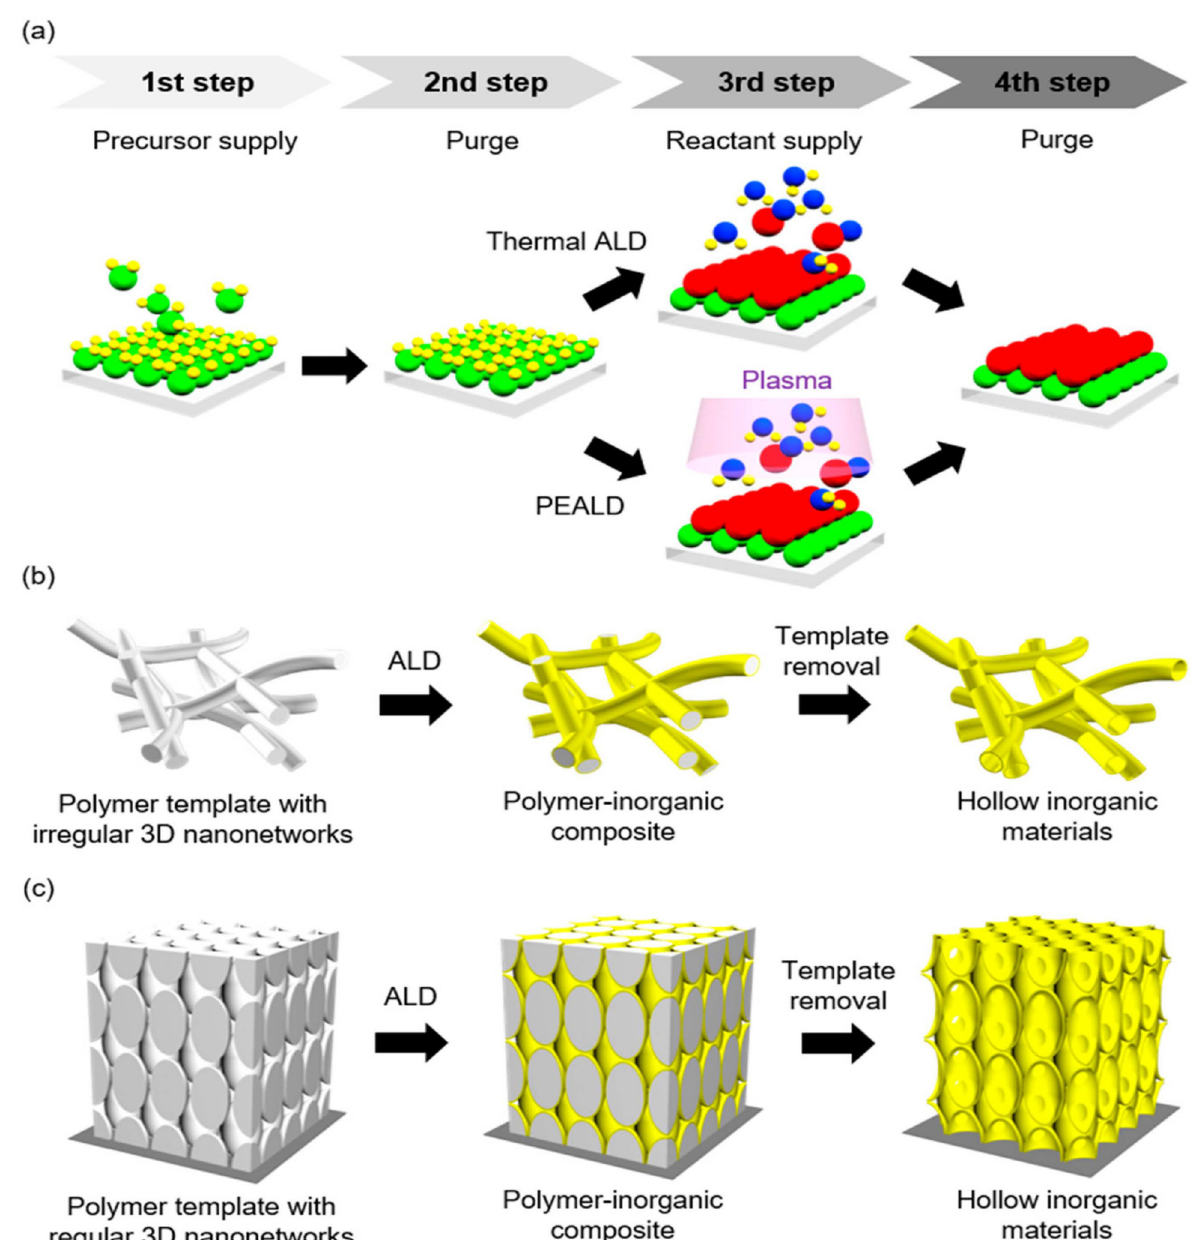
Figure 3: Illustration of ( a ) a cycle of thermal/plasma - enhanced atomic layer deposition, ( b ) the manufacturing process of hollow inorganic materials or polymer – inorganic composite from a polymer substrate with asymmetrical 3D nanonetworks, and ( c ) the manufacturing process of hollow inorganic materials or polymer – inorganic composite from a polymer substrate with regular 3D nanonetworks [ 66 ]